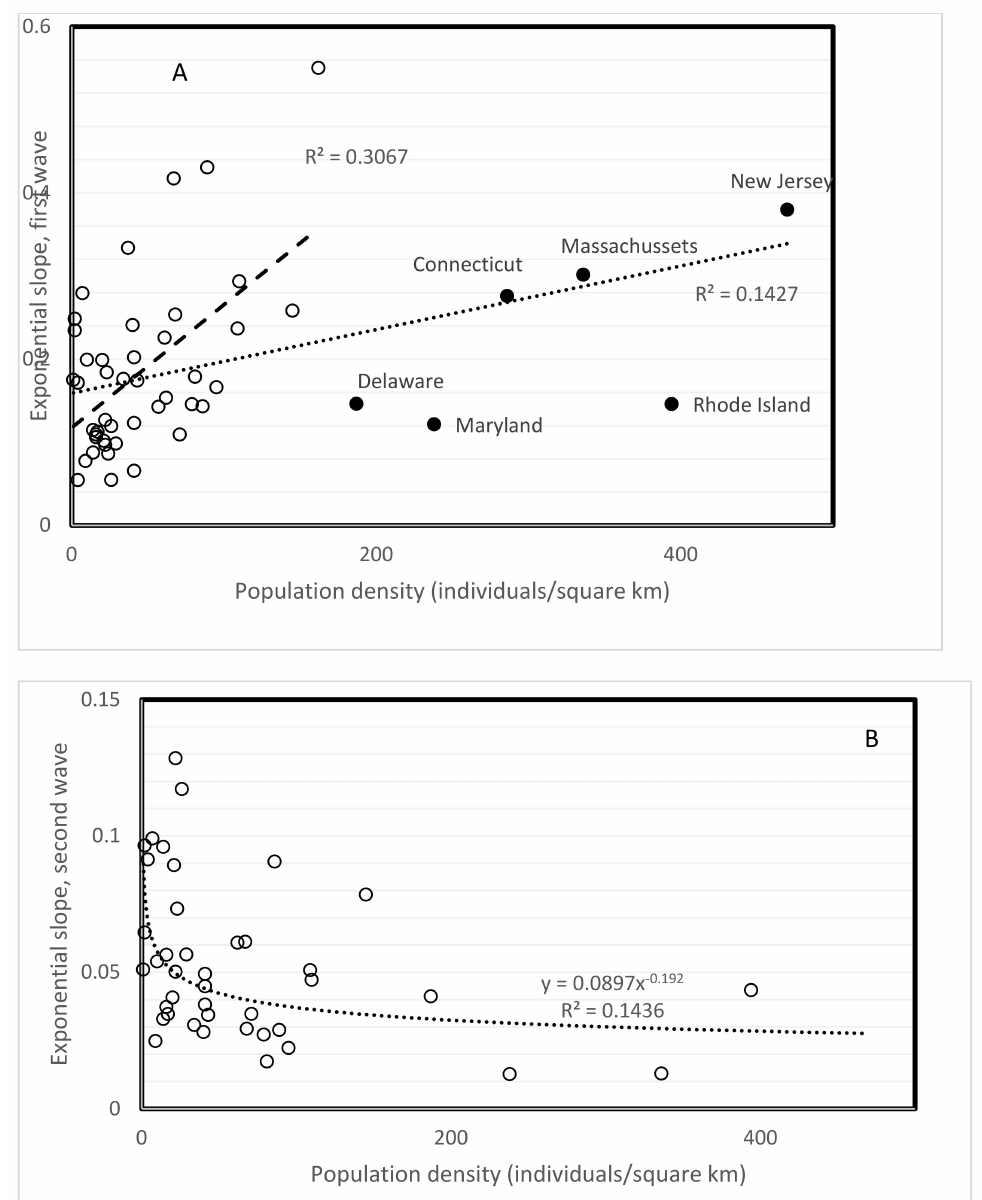
Figure 2. Spread parameters (slope of exponential regression) of first ( A ) and second ( B ) waves in USA states as a function of population density. Trend inverted between first and second wave. A: the New England states with high densities (filled circles) follow a different pattern than the rest of states, with a slower increase in spread with increasing density. B: the second wave slopes (as determined in August 2020) are overall lower than first wave slopes, and counter-intuitively decrease with population density. Patterns remain statistically significant with nonparametric Spearman rank correlation tests, see